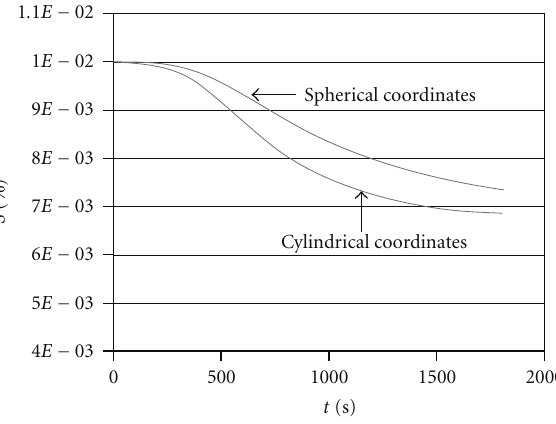
Figure 5: Sulfur elimination against time, node 40, T = 1400 ◦